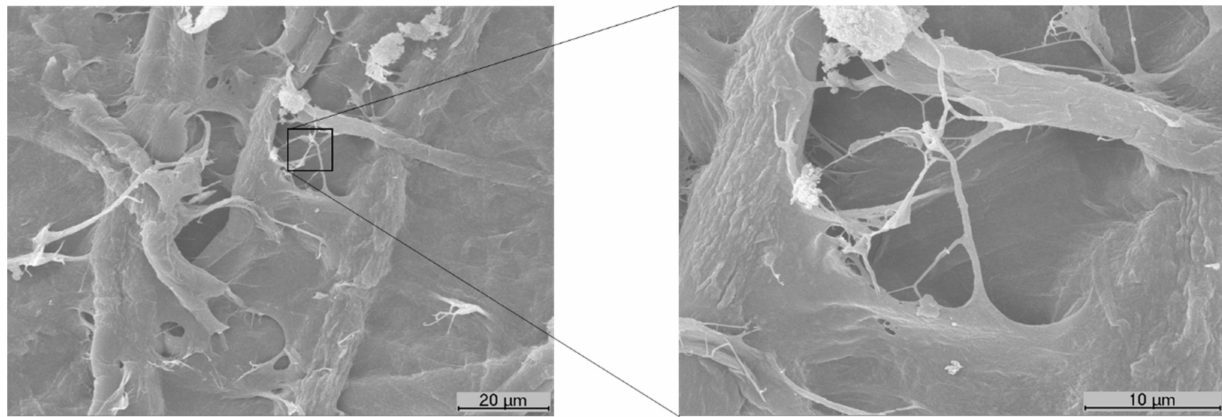
Figure 1. SEM image of the CMF additive, highlighting a high magnification image (3000 × ) where it is possible to verify the micro and nanofibrils of this